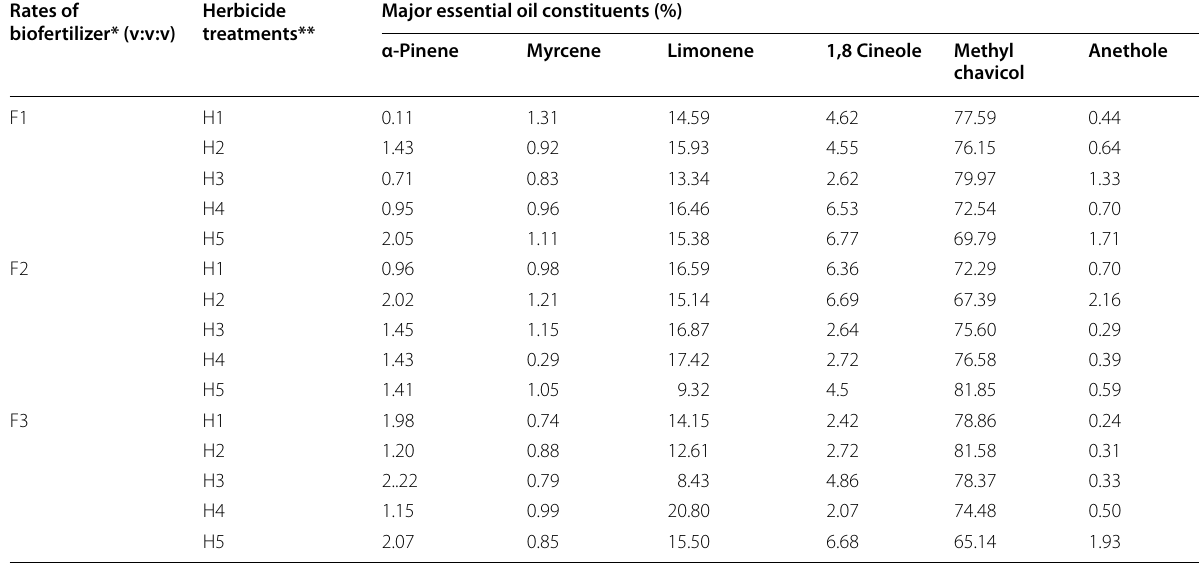
Table 5 Effect of biofertilizer and herbicides on fennel oil composition Rates of biofertilizer*